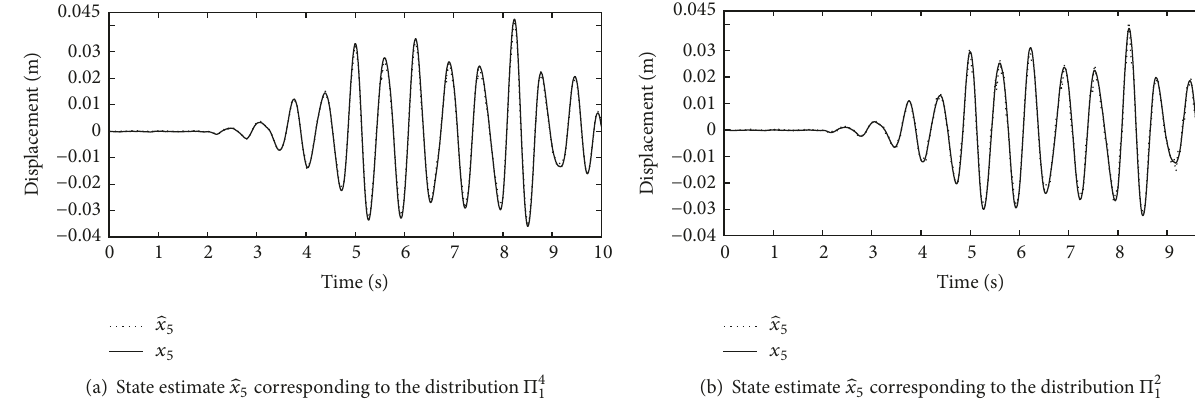
Figure 12: Estimates produced by the state observer in the distributions Π 4 1 and Π 2 1